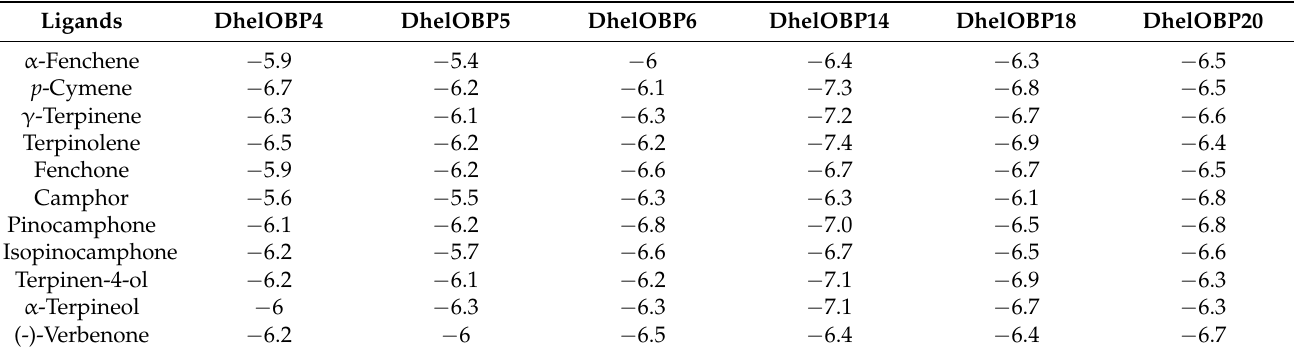
Figure 5. 3D structure models and binding cavities of target DhelOBPs. The binding cavities were formed by docking with 1-NPN and all tested HIPVs. Table 2. The predicted binding energy (kcal mol −1 ) of DhelOBPs and HIPVs.